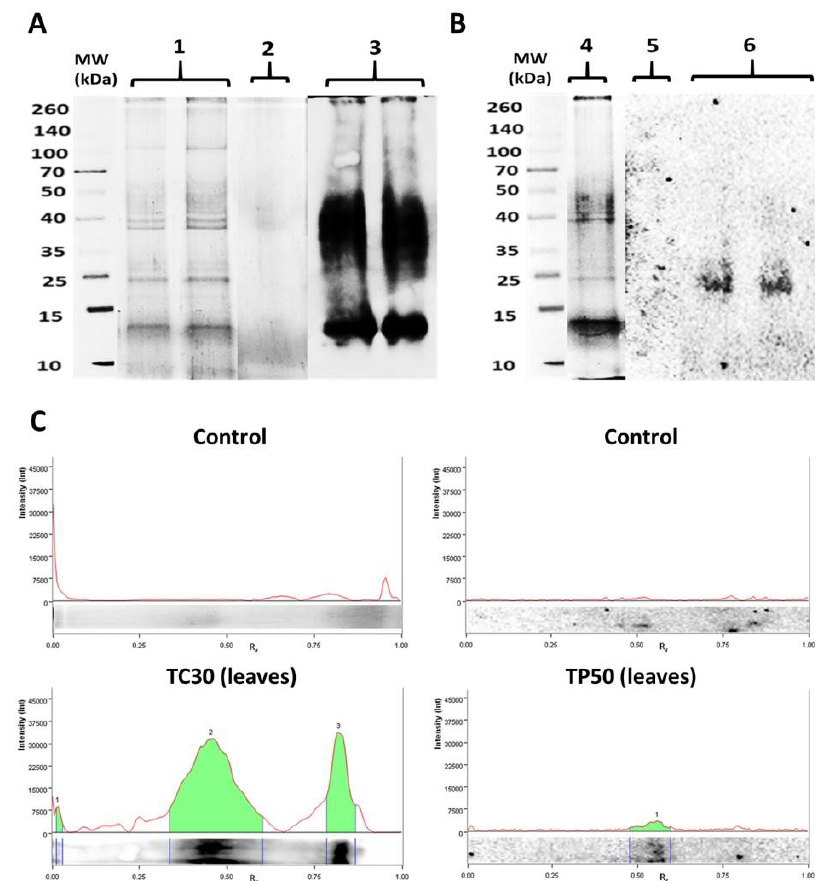
Figure 4. Carbonylation patterns in samples of P. fasciculatum exposed to Cd and Pb. ( a ) Protein profiles obtained for roots of P. fasciculatum exposed to 30 mg kg − 1 Cd for 30 days: electrophoregram of Blotting of Coomassie Blue (CBB) stained proteins on SDS-PAGE (1), oxyblots for 30 days’ control (2) and exposed samples (3). ( b ) Protein profiles obtained for leaves P. fasciculatum exposed to 50 mg kg − 1 Pb during 60 days: electrophoregram of CBB stained proteins on SDS-PAGE (4), Oxyblots for 60 days’ control (5) and exposed samples (6). ( c ) Densitograms with the intensity of the chemiluminescent signal for each carbonylated protein band obtained in oxyblots.